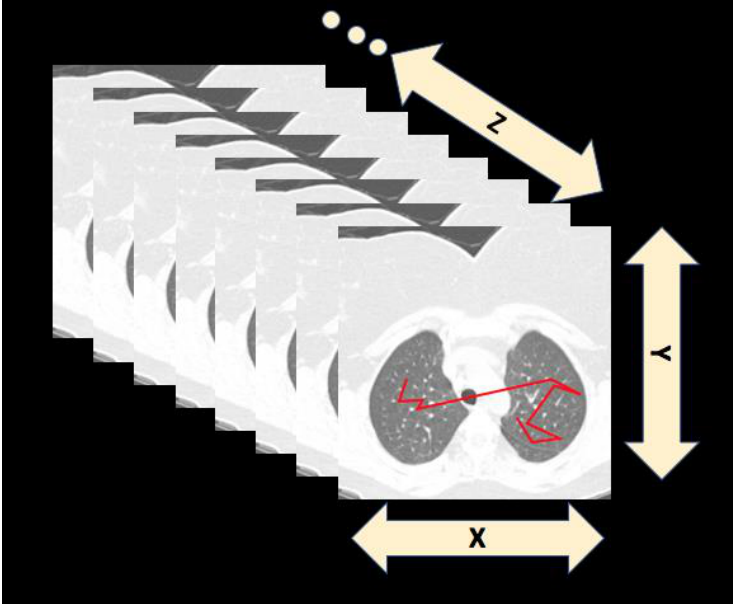
Figure 1. Eye tracking in 3D stacks of images means keeping track of the eye’s position in the XY plane and the depth (Z) of the currently displayed image.